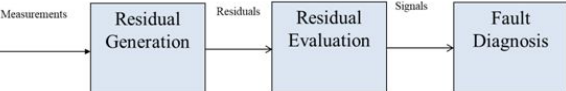
The fault diagnosis is performed by the model-based methods which are relied on analytical redundancy and analytical models expect the process behavior. The math- ematical model is exploited by analytical models of the monitored machine [9]. The residual generation methods based on this explicit model are utilized to obtain signals which are indicative of fault presence in the machine. The vibrationsignalsi.e.,theresidualsevaluation;thefaultde- tection and isolation are achieved as shown in Figure 2.